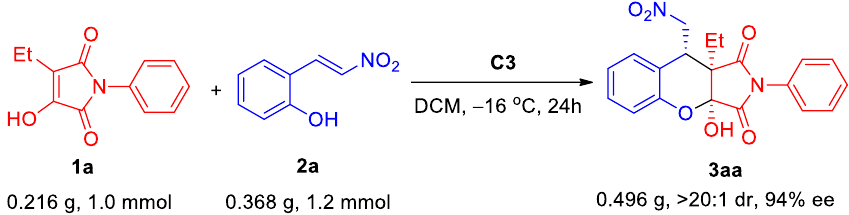
Scheme 3. Scaled-up synthesis of 3aa